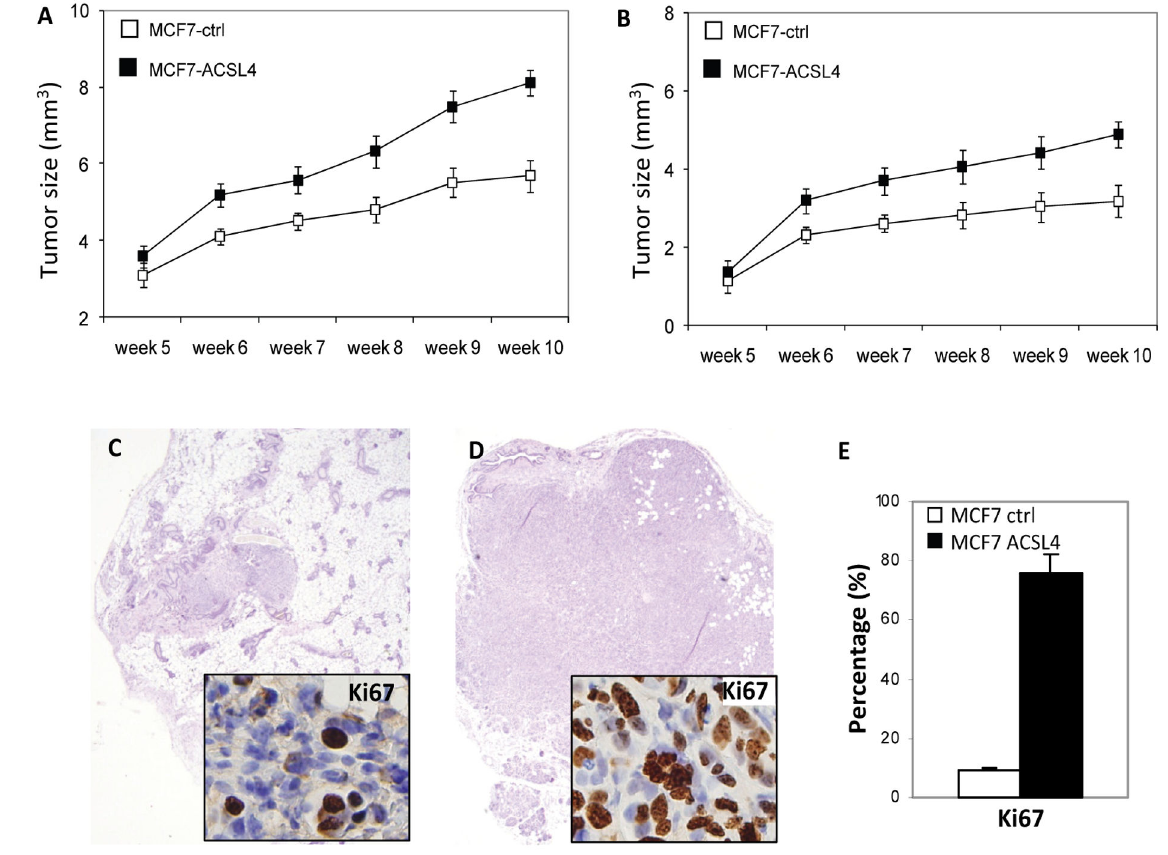
Figure 6. Comparison of the growth of control and ACSL4-MCF-7 cell tumors in nude mice. Nude mice, either intact ( A ) or ovariectomized ( B ) were injected with 1 × 10 7 MCF-7 vector control- (open circles) or ACSL4-transfected (open squares) cells. Each group contained 10 animals. The differences between the curves were significant ( A , p<0.0001 and B , p<0.0001). Panel C and D depict H and E stained samples from control and ACSL4-transfected tumors, respectively. Staining for Ki67 is shown in the inset of C and D. Panel E compares the percentage of cells in each sample that stain positively for Ki67. Three sections of each slide were analyzed to determine the significance of the difference